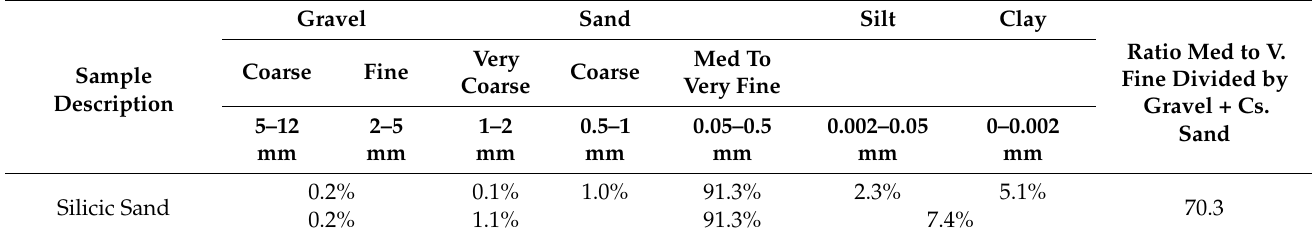
Table A5. Classification * of sand by comparison of the gravel, sand, silt, and clay distribution of the sample.